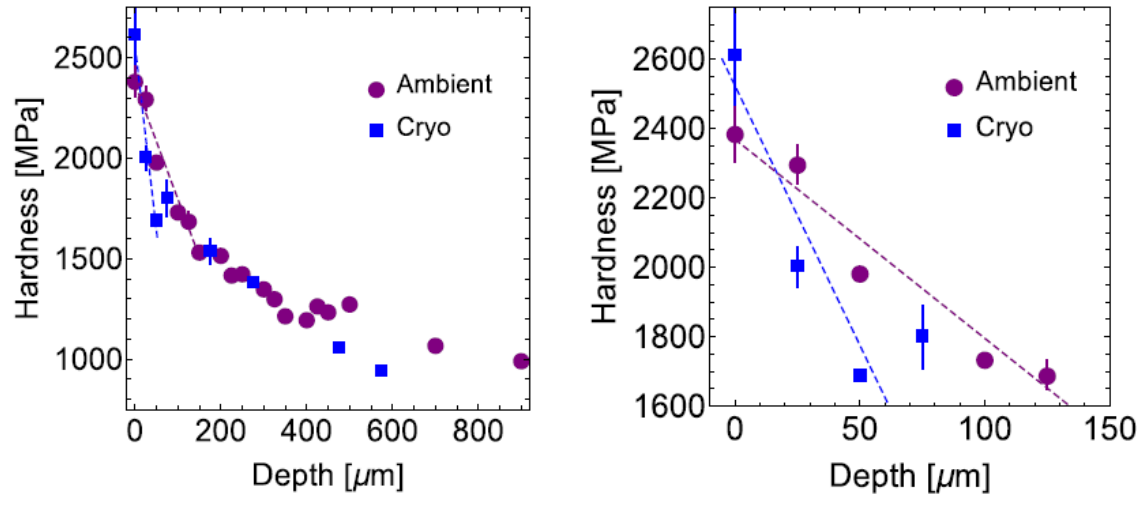
Figure 2. Microhardness of iron plates treated by the SMAT process as a function of depth into the sample. The values for the cryogenic SMAT iron are indicated by blue squares; ambient SMAT by purple circles. Dashed lines are a guide to the